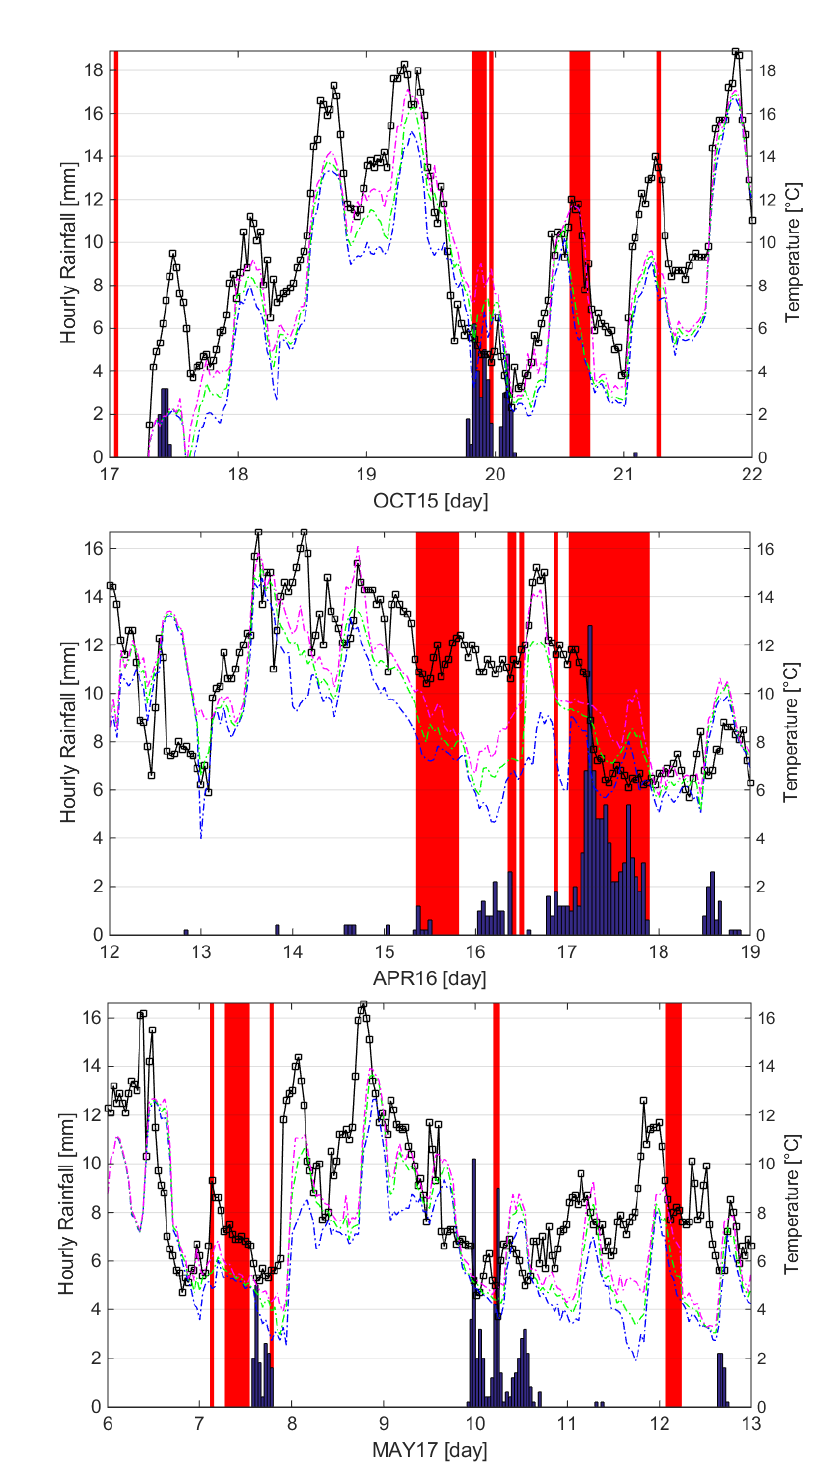
Figure 8. Ensemble performance for OCT15 ( upper plot), APR16 ( central plot) and MAY17 ( lower plot) events. Red stripes indicate WRF rain occurrence prediction when the ensemble probability of rain exceeds 0.5, and blue bars are the observed hourly precipitation in Apoquindo rain gauge. Temperature time series includes 25 (blue), 50th (green) and 75 (magenta) percentiles for the ensemble forecast against observed data (black